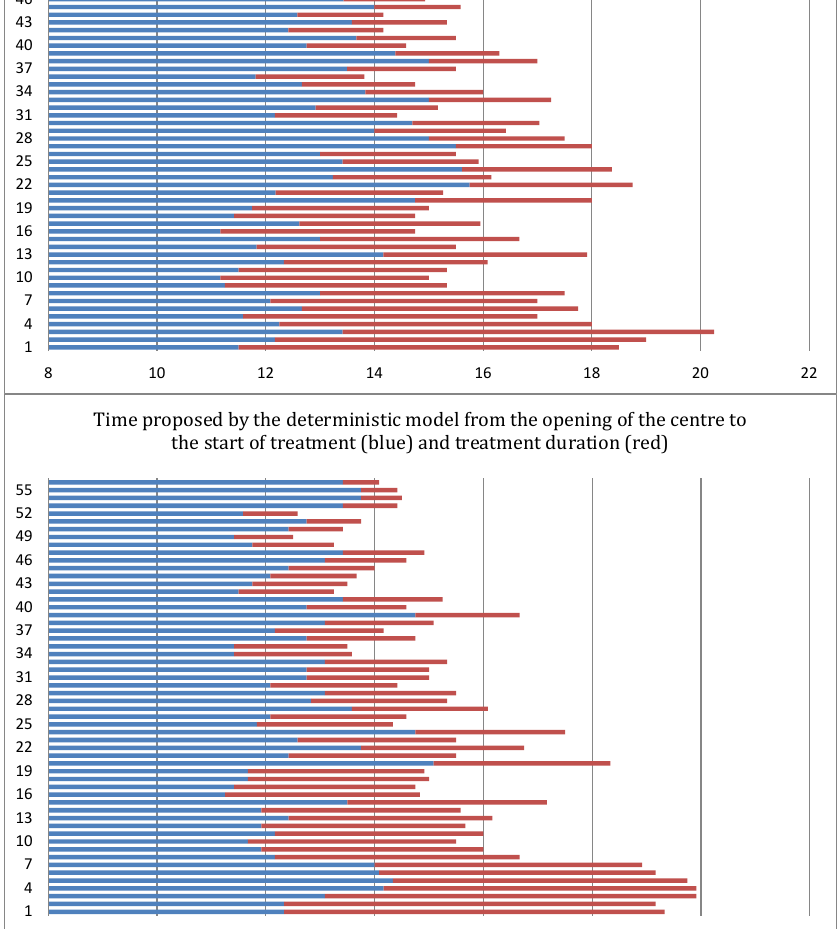
Figure 9. Time elapsed from the opening of the centre to the start of treatment (blue colour) and treatment duration (red colour) on Monday 11 January 2021: actual data (top) and data proposed by the deterministic model with time margins of 120 min (bottom). Patients have been ordered from down to up from the longest to the shortest treatments. X-axis: time of day between 8:00 and 22:00 h. Y-axis: patient